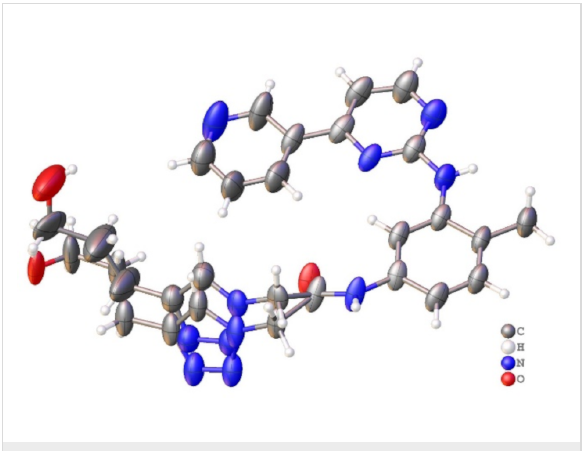
Figure 2: Asymmetric unit representation of the 1,2,3-triazole deriva- tive 2b . Displacement ellipsoids are drawn at the 50% probability